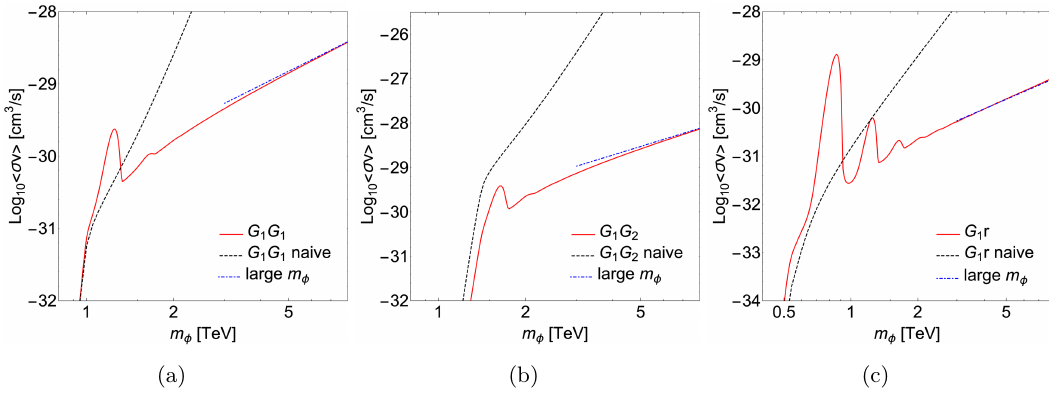
Figure 5 . Thermally averaged cross section into the a) G 1 G 1 , b) G 1 G 2 , and c) G 1 -radion final state for a representative set of parameters ( Λ = 20 TeV, m 1 = 1 TeV and m r = 100 GeV). The full numerical result obtained by including the KK-tower up to the first 20 gravitons is shown in red (solid) while the naive result obtained by truncating the tower after the highest graviton in the final states is shown in black (dashed). In blue (dot-dashed) we show our approximation for the high m φ limit. The temperature is taken to be T = m φ / 20 as in figure